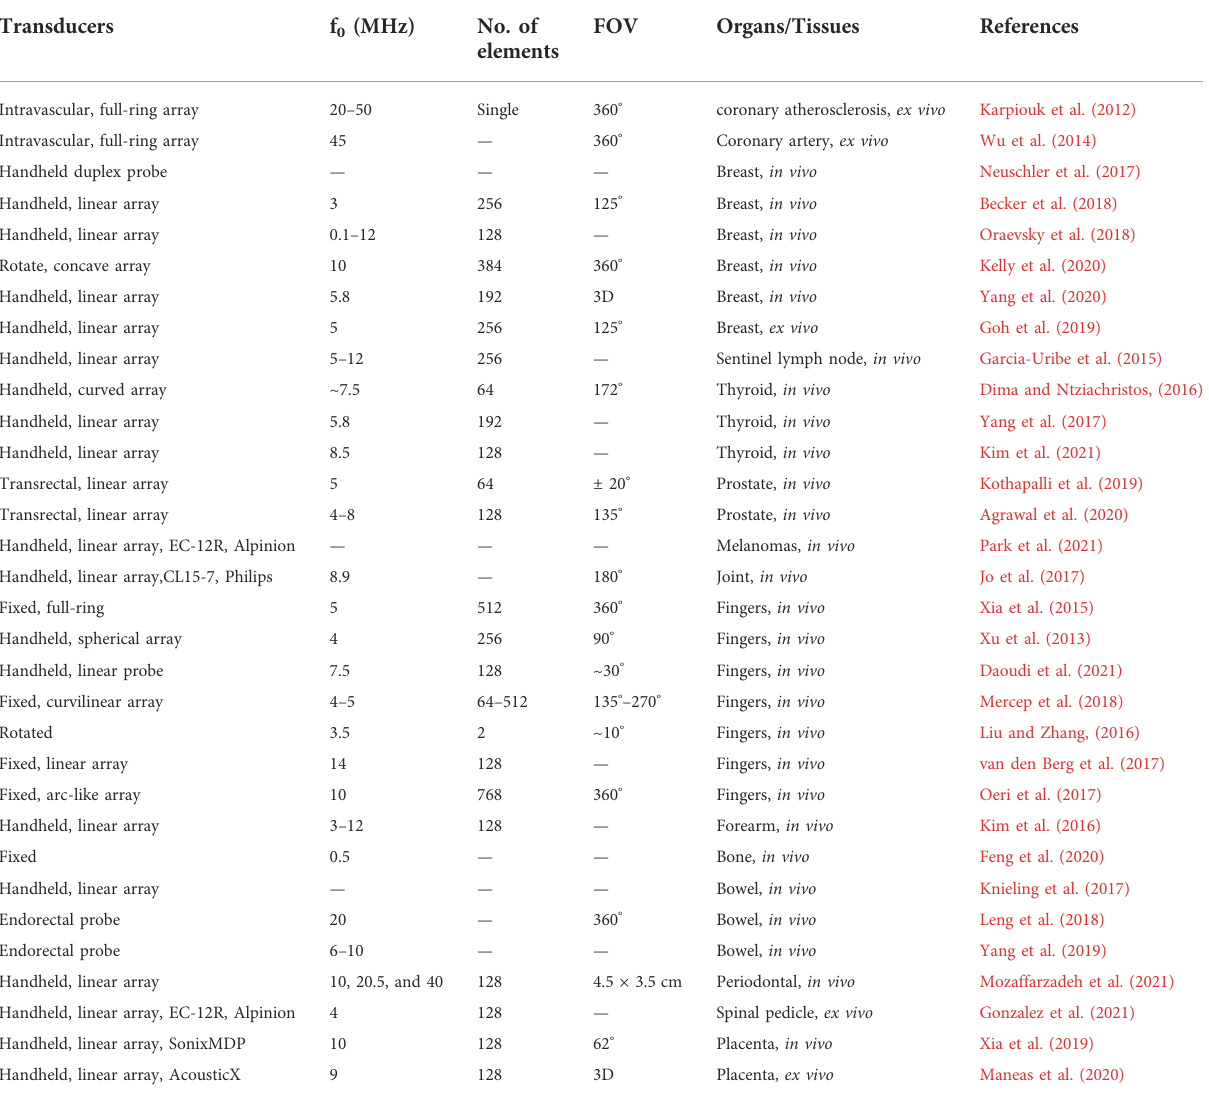
TABLE 1 Comparison of various con fi gurations for clinical PAT/US dual-modal